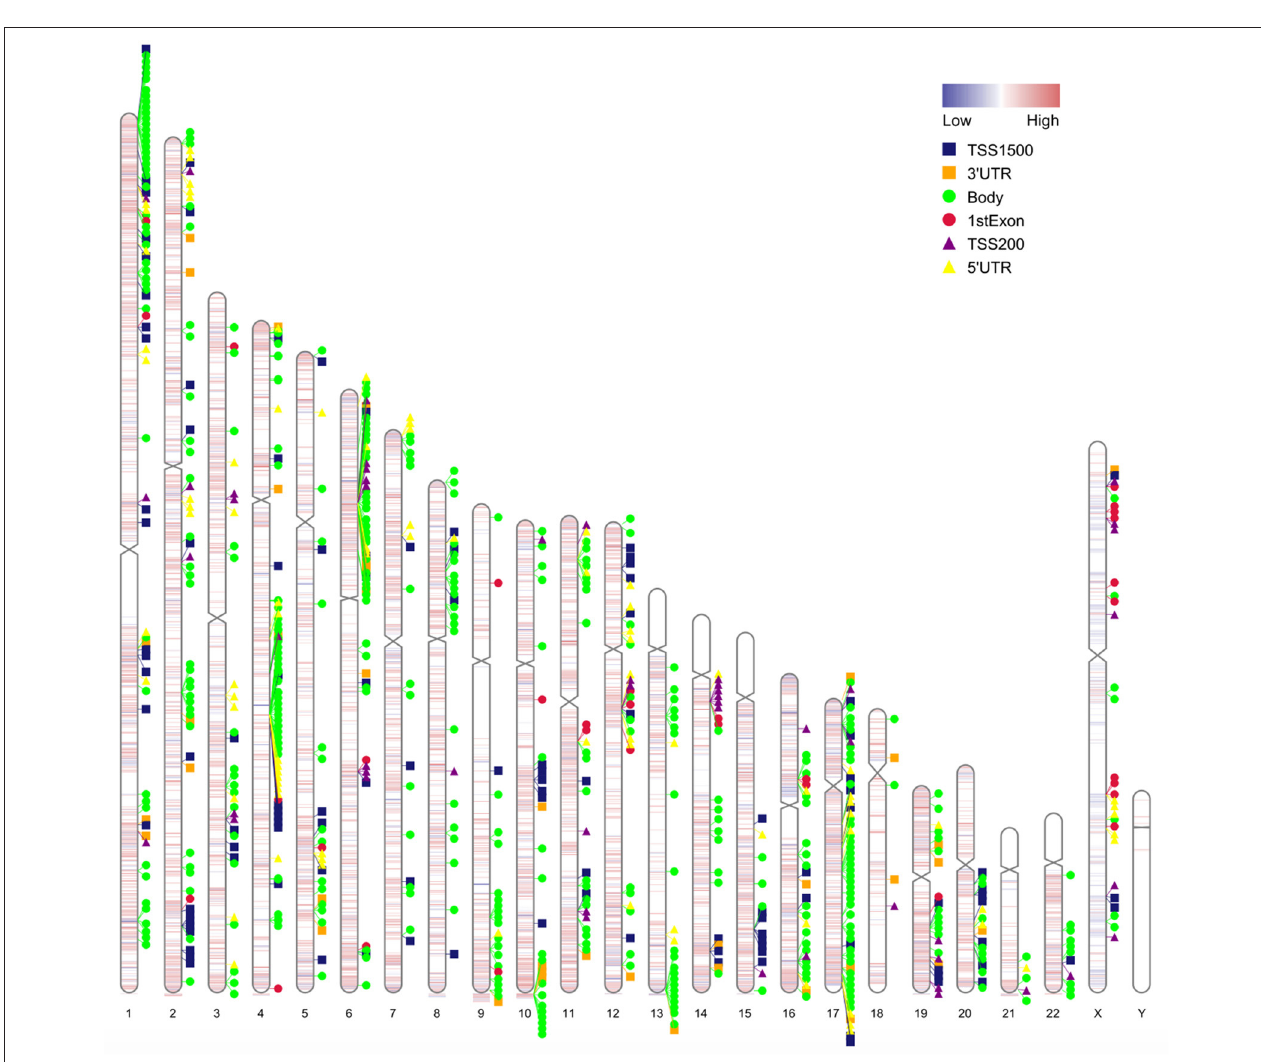
FIGURE 4 | Chromosome distribution of differentially methylated intergenic CpGs. Plot showing the distribution of differential intergenic CpG sites on 22 autosomes and the X and the Y chromosomes. Red is the hypermethylated region and blue is the hypomethylated region with logFC values of the M value between obesity patients and healthy